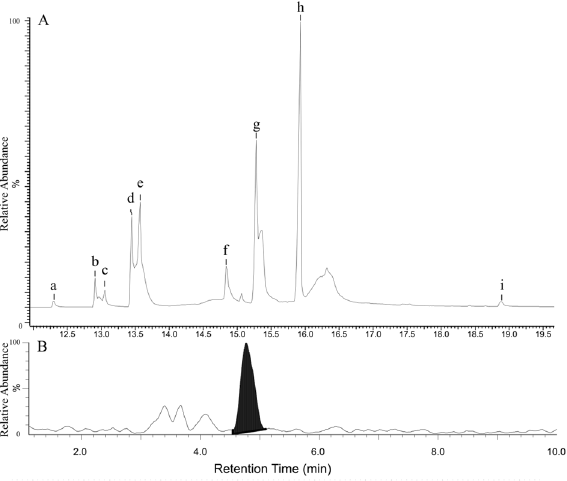
Figure 2. GC results ( A ) indicating the presence of 2-phenylethylamine (a), 3,4-dimethoxyphenethylamine (b), tyramine (c), N-methylthyramine (d), hordenine (e), mescaline (f), trichocereine (g), N-methylmescaline, (h) and N-acetylmescaline (i). HPLC results ( B ) showing the presence of dopamine (black